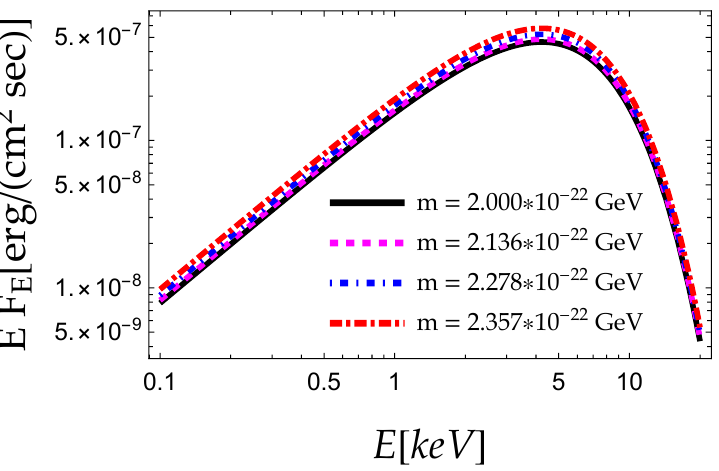
Figure 4. Soft X-ray emission from the black hole accretion disc assuming D = 10 kpc, i = 70 ◦ , f col = 1.6 and M = 30 M (cid:12) for different values of the mass parameter m . The spectrum is slightly enhanced with m